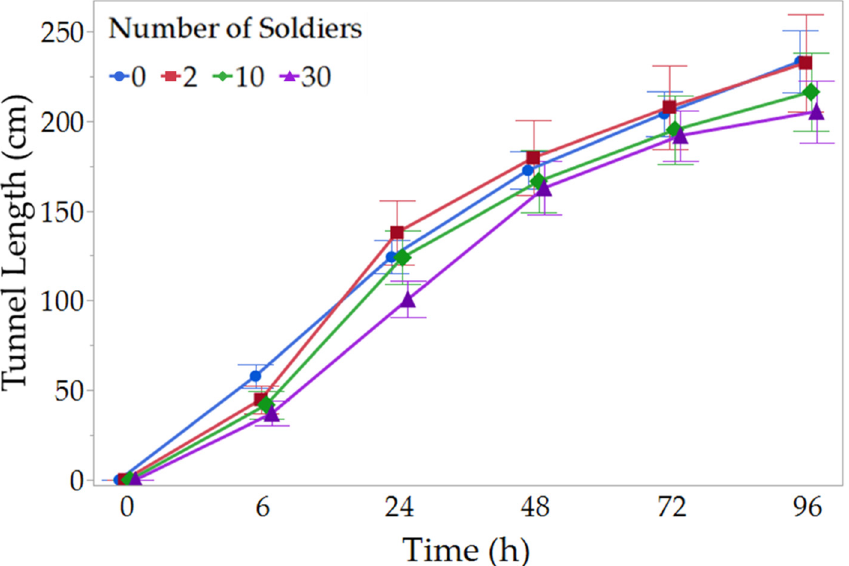
Figure 2. Changes in total tunnel length during exploratory foraging phase. Tunnels were constructed by groups of 100 foraging workers with different numbers of soldiers. Data shown are means ± SEM. No significant difference was detected among treatments at any time point (LMM, p > 0.05, n = 16).